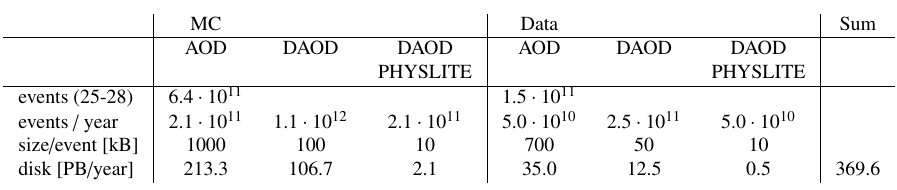
Table 4: Overview of a very simple disk space model extrapolation for the HL-LHC applying the AMSG-R3 recommendations as described in the